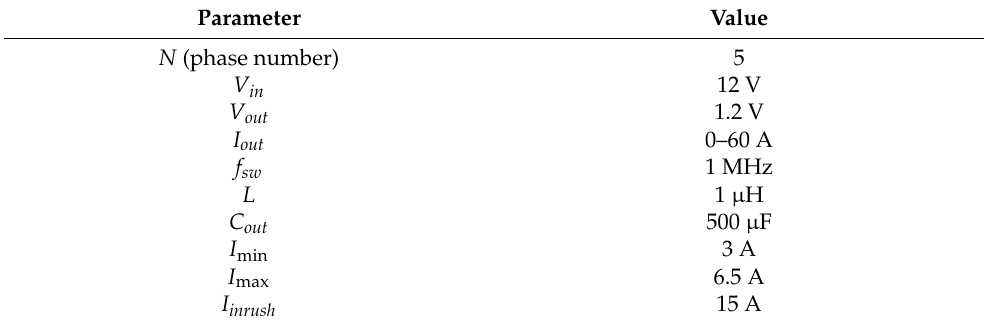
Table 1. Parameters of the multiphase converter supplying a multicore 1.2 V/60 A microprocessor.